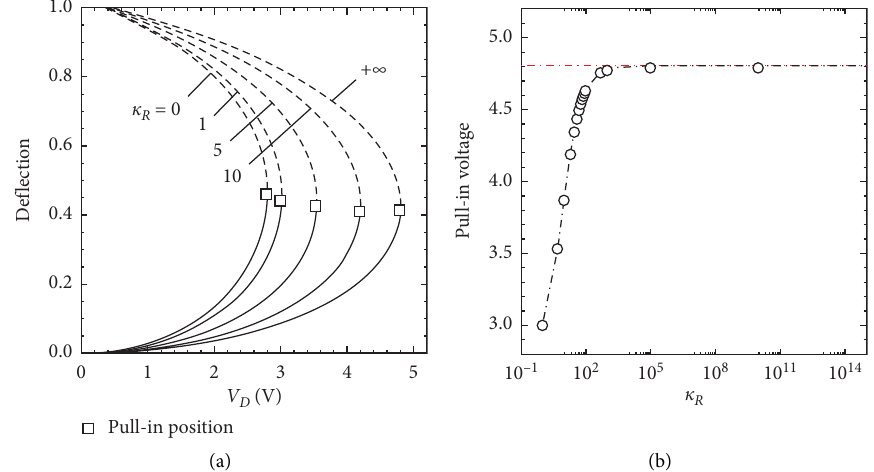
Figure 3: The effect of rotational stiffness on static features by applying the first five-order symmetry modes. (a) Relationship between maximum static deflection and DC voltage under different rotational stiffness. (b) Variation trend of the pull-in voltage with rotational stiffness.